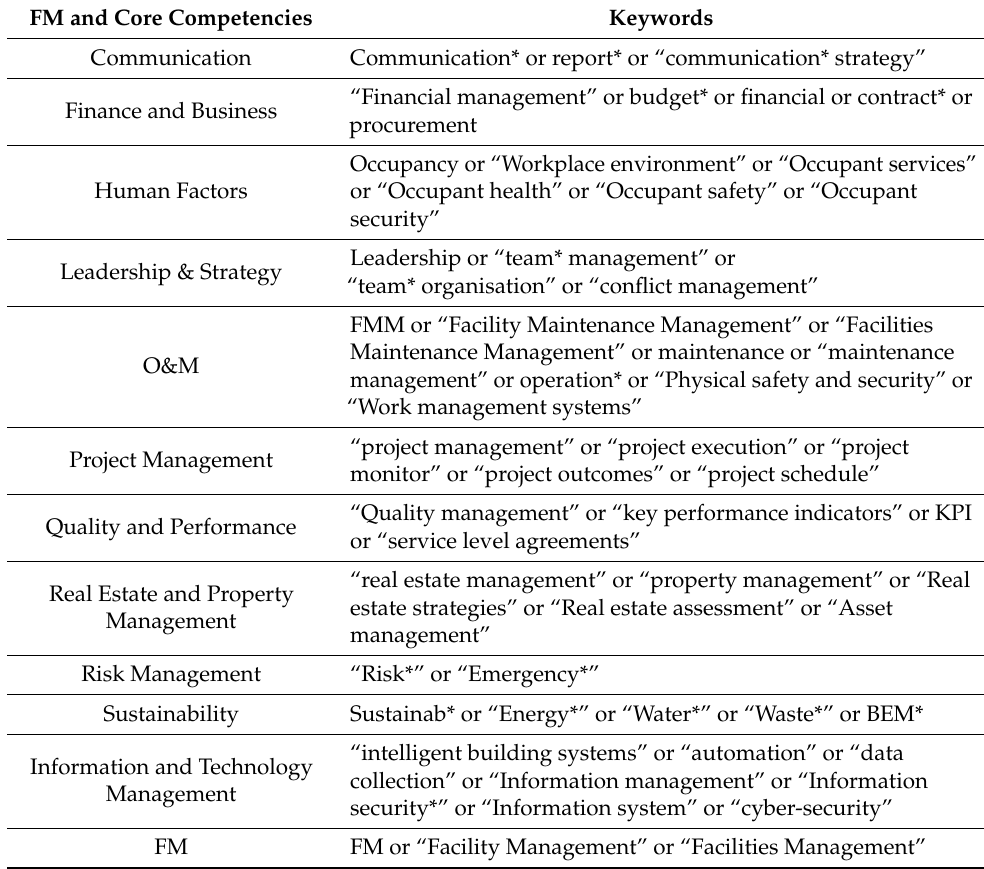
Table 2. FM and its core competencies keywords used for research in the two electronic databases of peer-reviewed literature Scopus and Web of Science